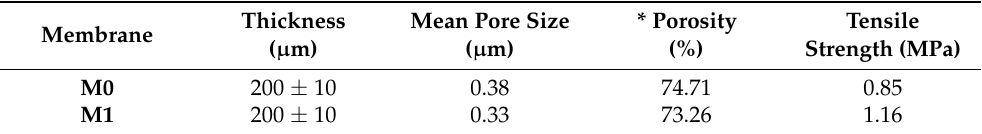
Table 1. Pore size, porosity, and tensile strength of M0 and M1. Membrane